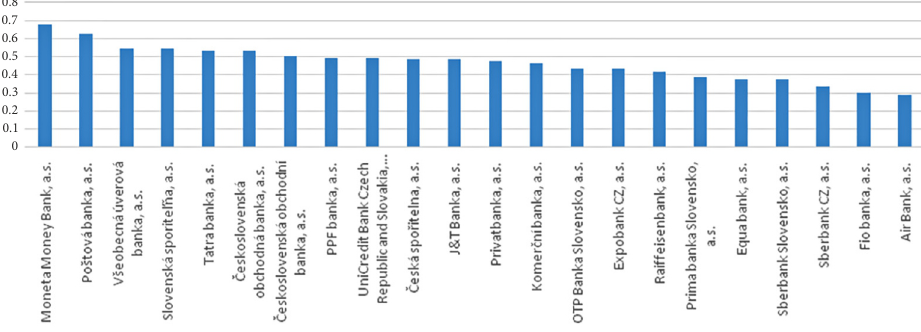
Fig. 2. Aggregated performance index of analyzed Czech and Slovak banks Source : prepared by